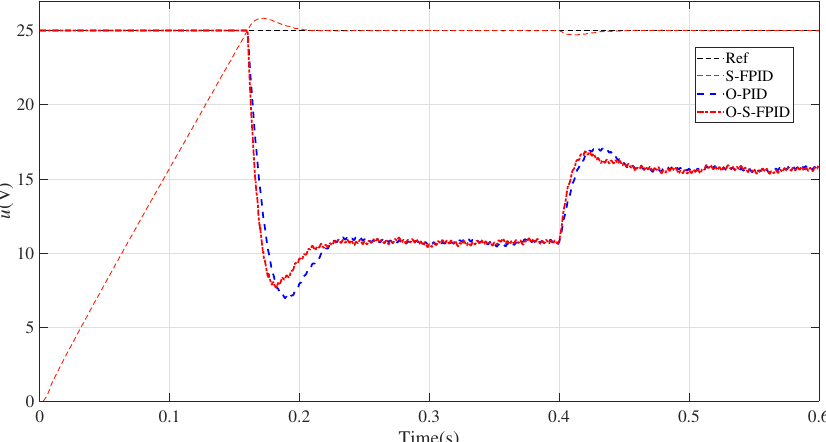
Figure 11. Comparison of controller output values under step response.